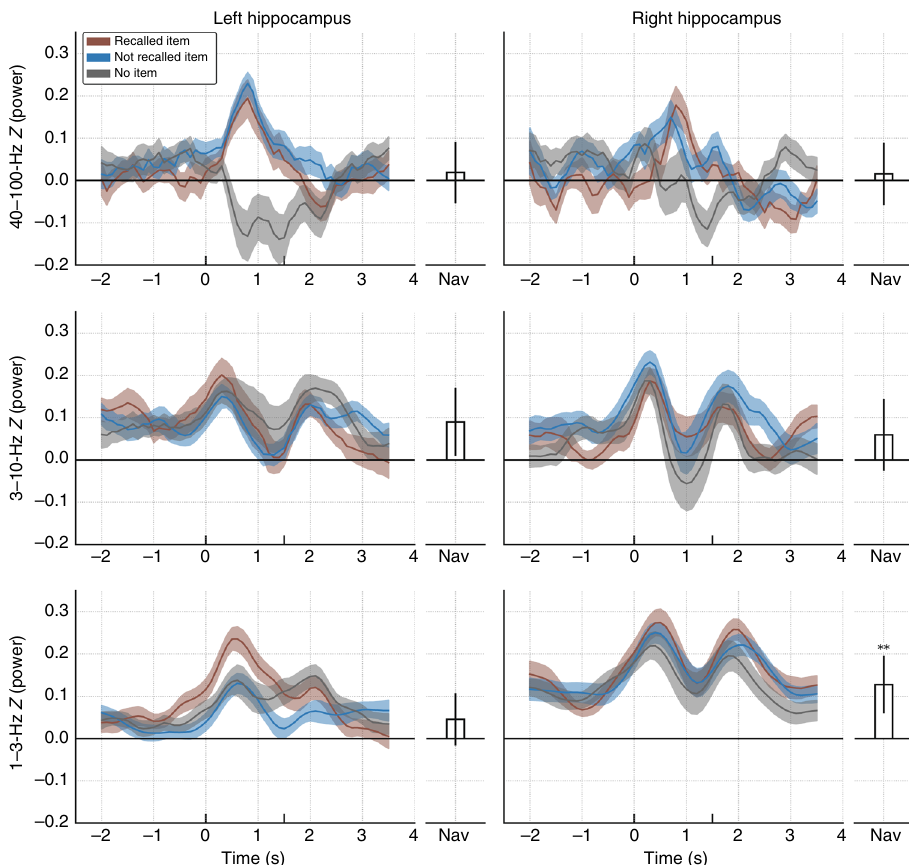
Fig. 5 Time courses of 1 – 3-, 3 – 10-, and 40 – 100-Hz power before, during, and after item presentation for left ( N = 26) and right ( N = 21) hippocampus. All power values are z -scored relative to the pre-trial baseline periods. Red lines indicate power for subsequently recalled items, blue: not recalled items, gray: empty chests (no item). Chests open to reveal an item (or no item for the gray line) at 0 s (onset) and disappear at 1.5 s (offset). Shaded errors regions are ±1 within-subject SEM 70 . The Nav bar represents average power during navigation epochs (periods spent driving to chests), shown with 95% con fi dence intervals. ** p < 0.01, Bonferroni